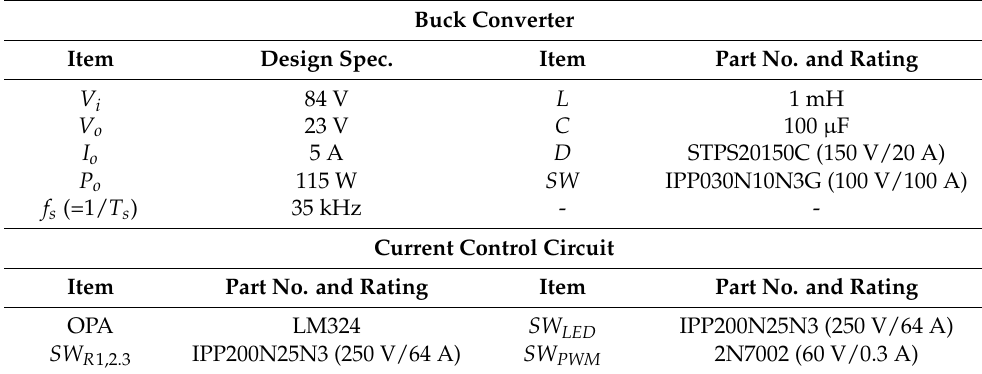
Table 1. Design specifications and selected parameter values of components of buck converter and current control circuit. Buck Converter Item Design